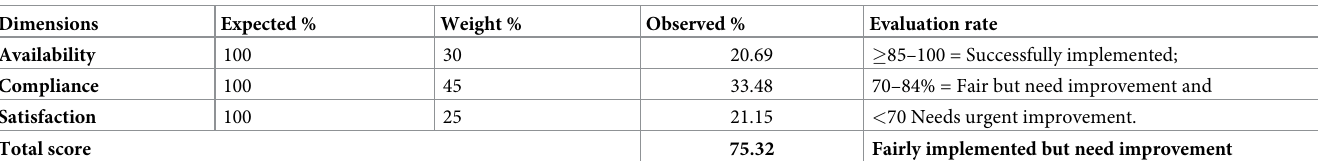
Table 7. Summary of judgment matrix for processes pediatric ART service in GCAHCs, April